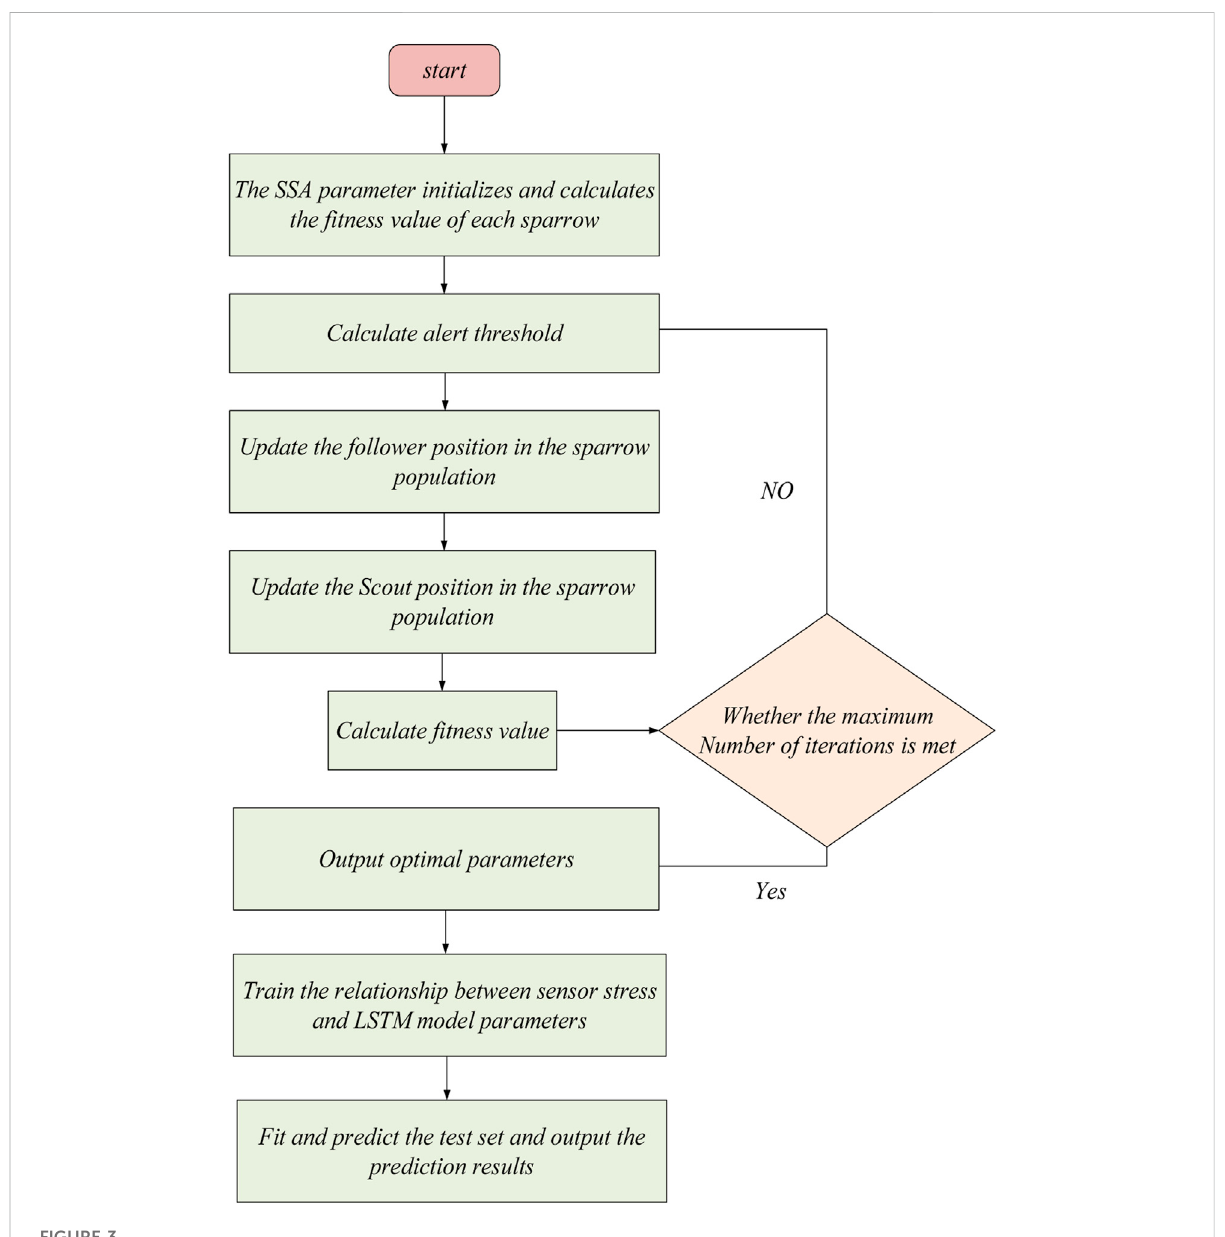
FIGURE 3 Flow chart of LSTM optimized based on